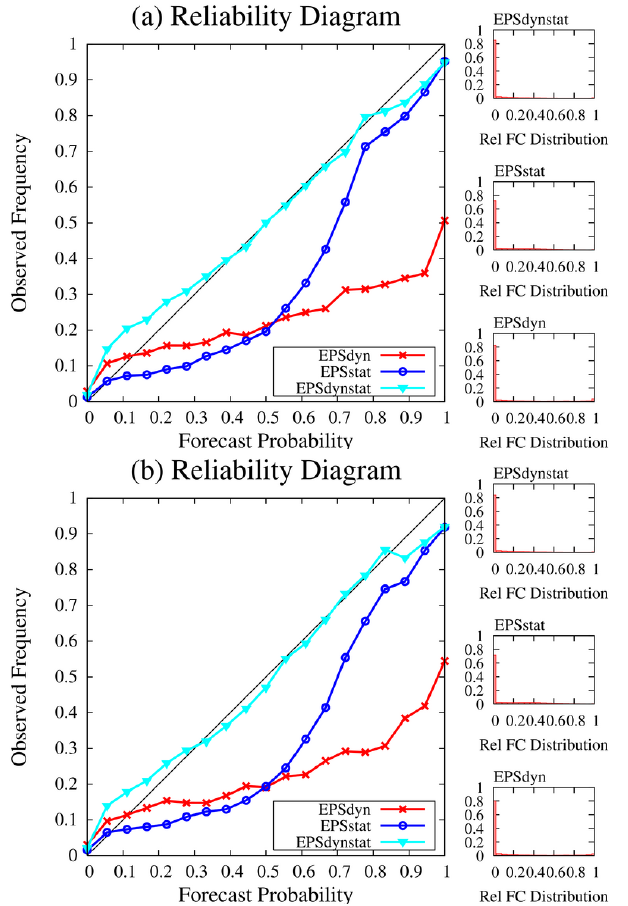
Figure 6. Reliability diagram for +6 hours (a) and +24 hours (b) from the dynamical (red), statistical (dark blue) and dynamic-statistical (light blue) method. Threshold: 5 m/s.